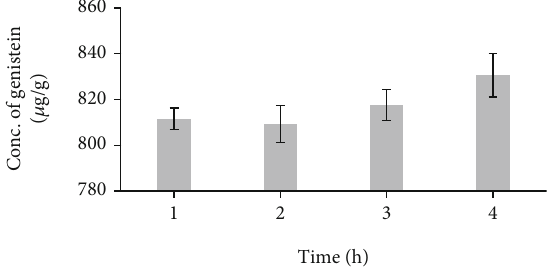
Figure 7: In fl uence of di ff erent time limits on Cuminum cyminum genistein content. (100mL of solvent (50 mL Methanol+25 mL Dimethyl sulphoxide+25 mL Water ( v / v / v ) and temperature, 80 ° C). (The bars show the mean values from three replicates ( n = 3 ) with the respective standard deviations).